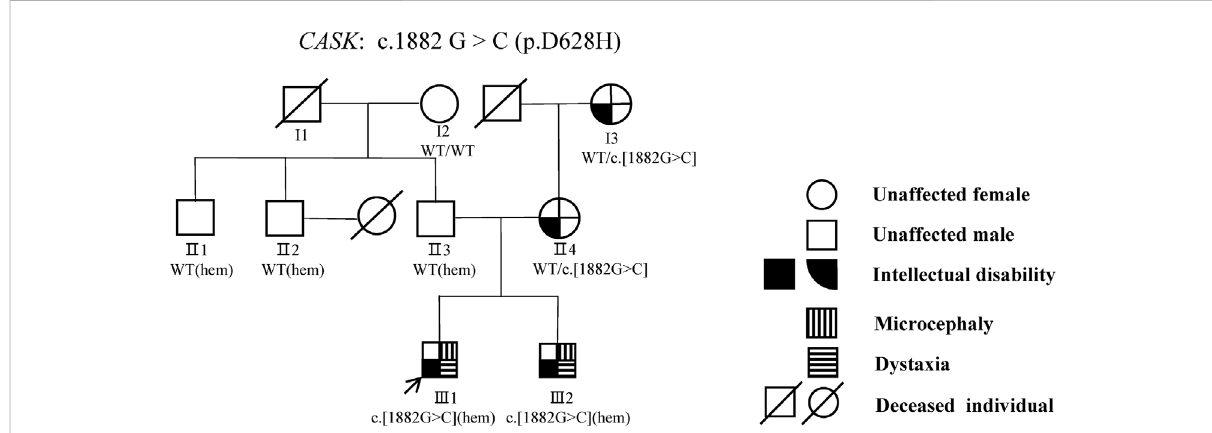
FIGURE 1 Pedigree of a three-generation family suffering from spinocerebellar ataxia. Males are represented by squares and females by circles. Intellectual disability is indicated by a black square, dystaxia by parallel horizontal lines, and microcephaly by parallel vertical lines. The black arrows indicated the probands (III1) mut+, mutation present; wt, wild type, het, heterozygous; hem,